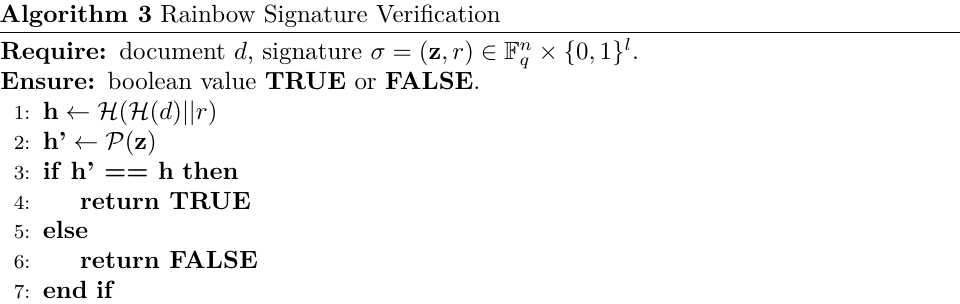
Algorithm 3 Rainbow Signature